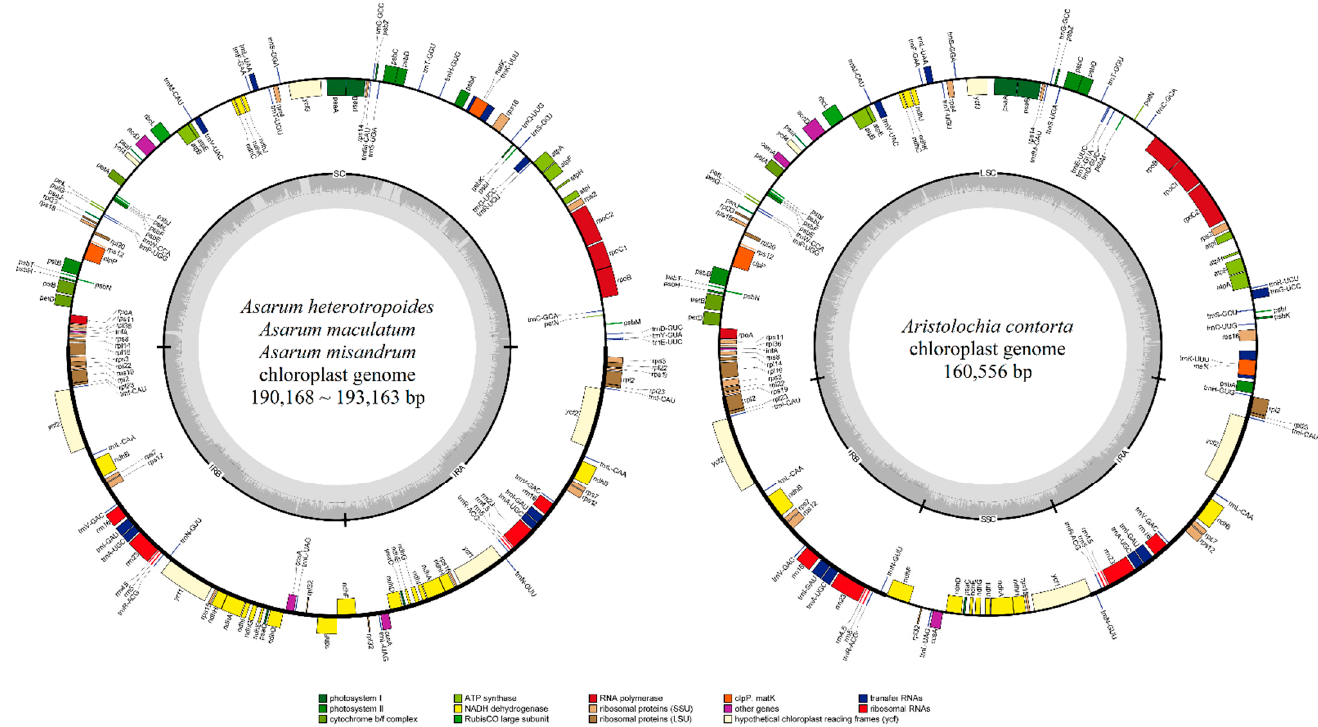
Figure 1. The plastome maps of three Korean Asarum ( left ) and one Aristolochia ( right ) species. Genes are represented in different colors according to their functions. Transcriptional directions are denoted on the inside (clockwise) and the outside (counterclockwise) of the circle. Table 1. Plastome characteristics in the four Korean Aristolochiaceae species.